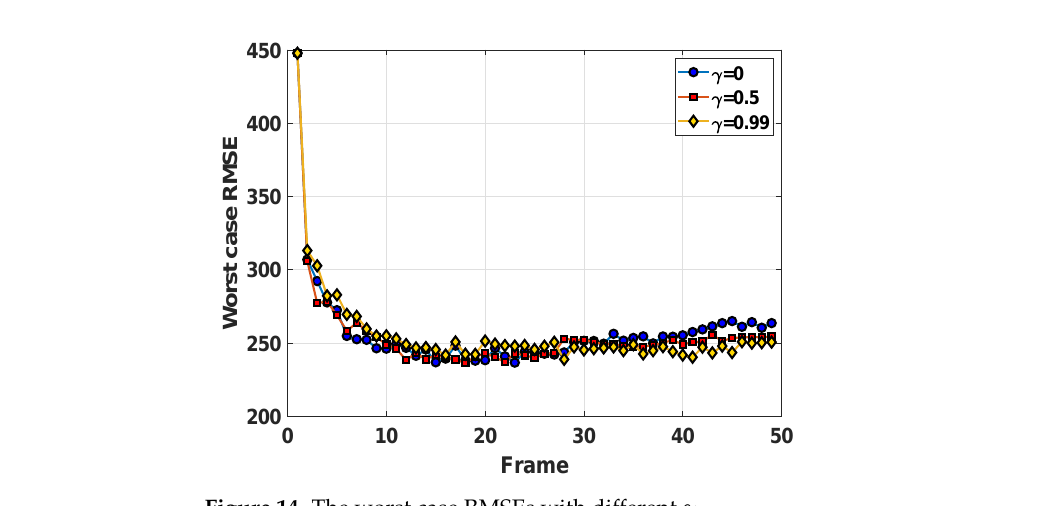
Figure 14. The worst case RMSEs with different γ .